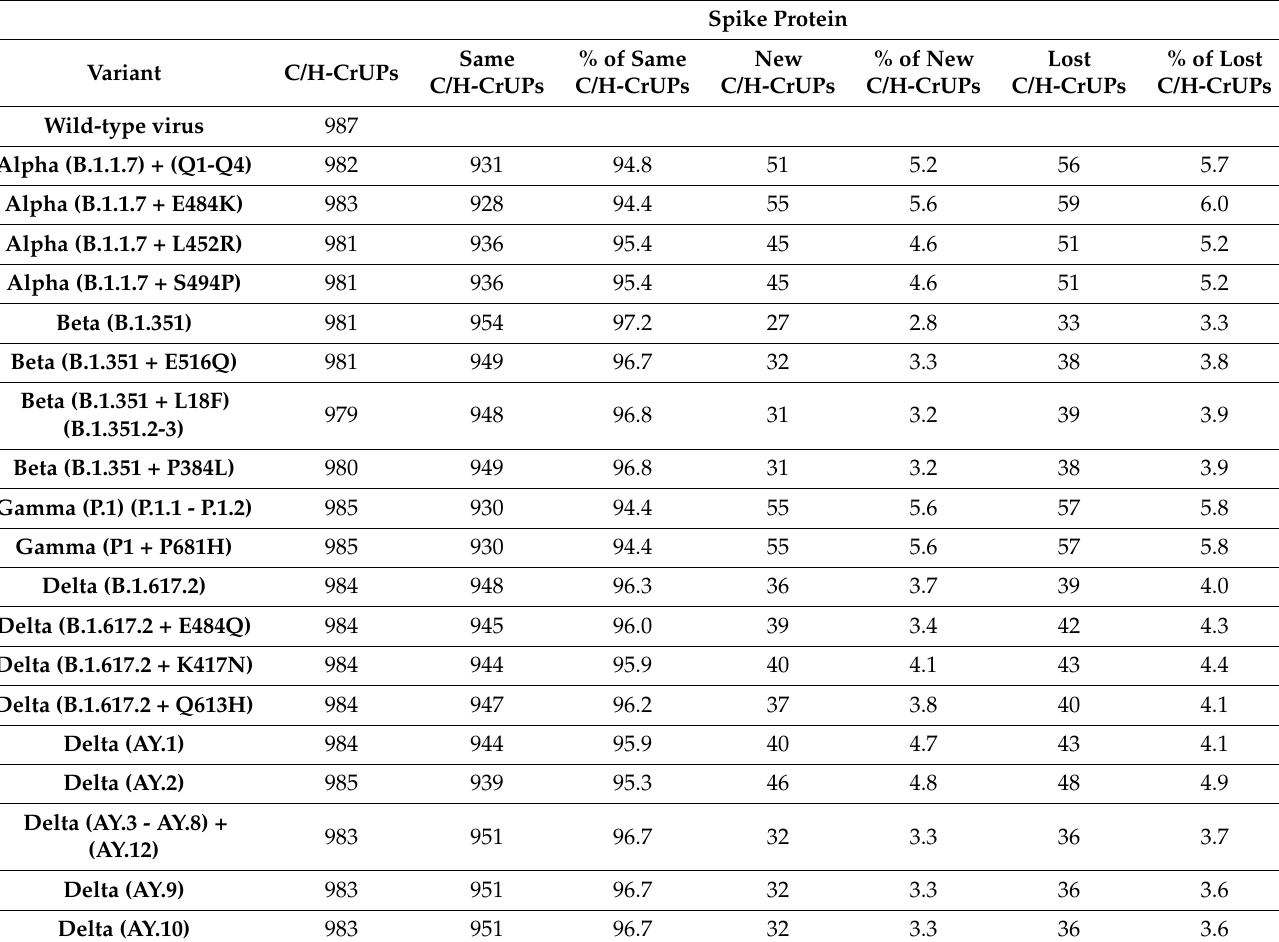
Table 1. SARS-CoV-2 Spike protein C/H-CrUPs across variants, as compared to the wild-type virus respective sequence. Spike